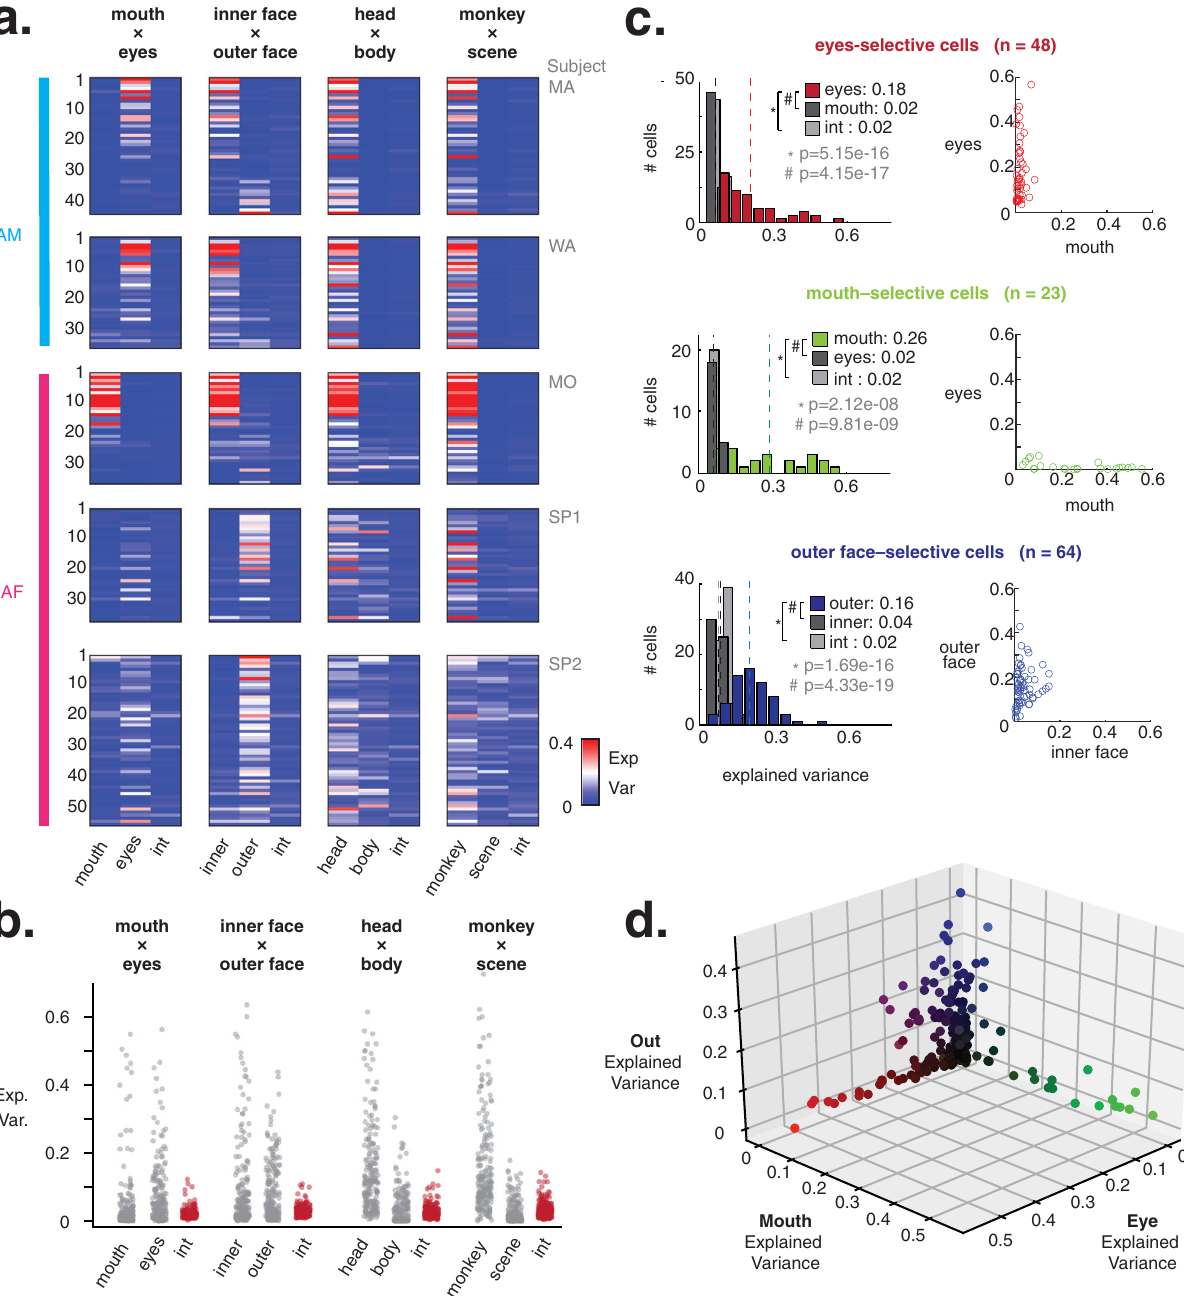
Fig. 3 | AM and AF neurons show strong parts-based tuning. a Heatmaps of response variance (2-way ANOVA) explained by each swapping factor and inter- action(e.g., eyes, mouth, eyes×mouth) forface-selective cellsat AM(blue)and AF (pink) sites. Most cells show high explained variance by one feature per swapping group. b Portion of response variance explained in each swapping category by the respective swapping factors (gray) and by the interaction term (red). Variance explained by the interaction of parts is low across all sites and all swapping cate- gories. c Classi fi cation of neurons as eyes-selective (top, red), mouth-selective (middle,green),orouterface-selective(bottom,blue).Left,histogramsofvariance